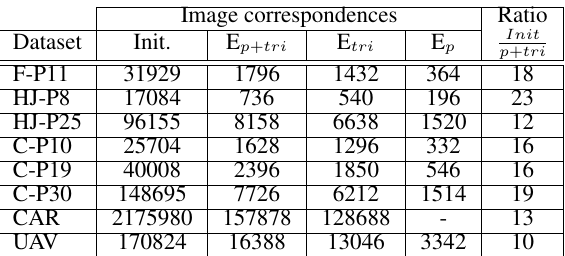
Table 3. Number of extracted features in respective datasets. Init are the features extracted with SIFT (Lowe, 2004), E p , E p + tri and E tri are respectively the fictitious image points derived from structure approximated on pairs, pairs and triplets, as well as triplets only. points. The reported results are always a mean value over 100 or 1000 repeated random calculations. In the bundle adjust- ment, the reduced points are weighted according to the